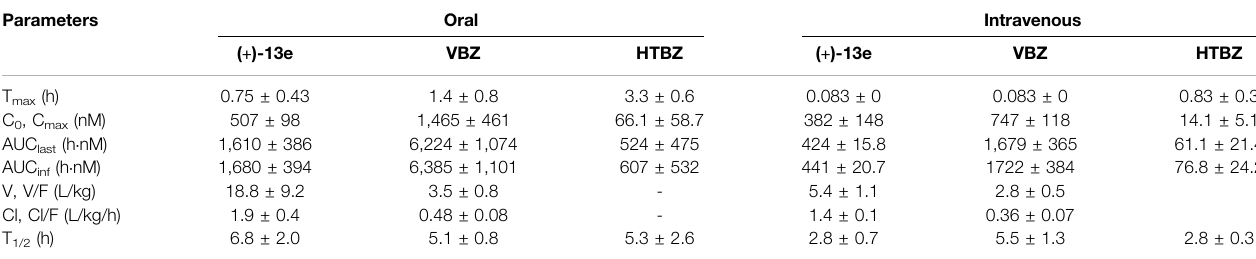
TABLE 5 | The pharmacokinetic parameters of (+)-9-tri fl uoroethoxy- α -dihydrotetrabenazine [(+)-13e], valbenazine (VBZ), and its active metabolite (+)- α -dihydrotetrabenazine (HTBZ) in dog plasma after a single oral dose at 3 μ mol/kg (n (cid:1) 4) and single intravenous dose of 0.6 μ mol/kg (n (cid:1) 3).